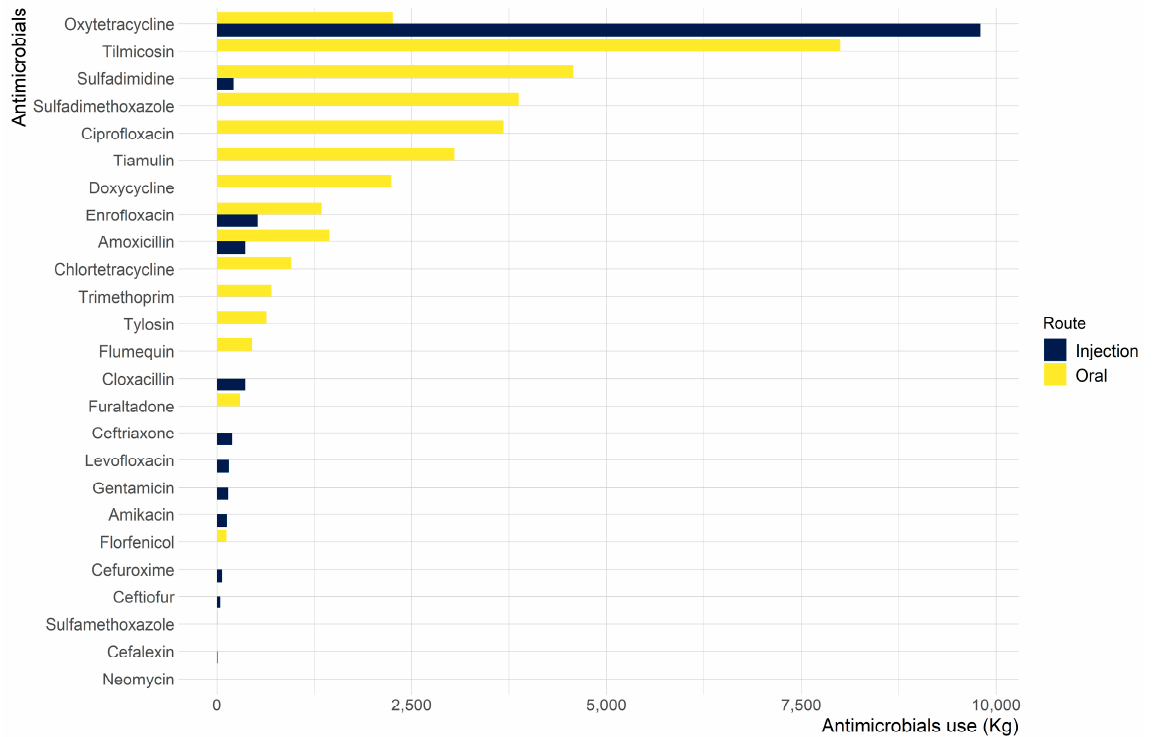
Figure 2. Antimicrobial quantities (by antimicrobial agents and route of administration) reported for use in veterinary medicine in Nepal in